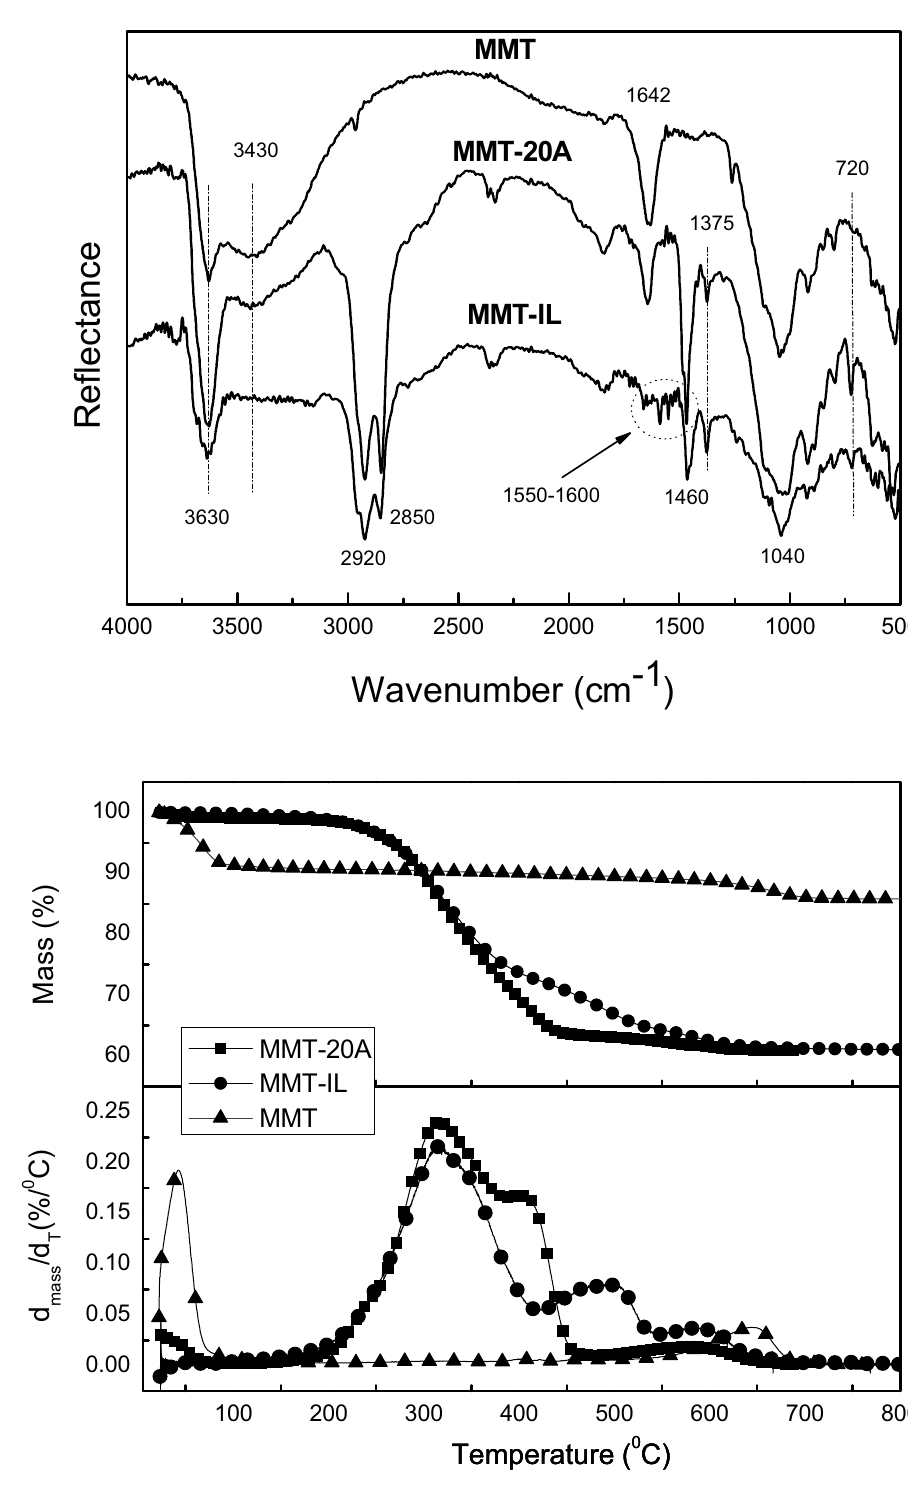
Fig. 3 FTIR spectra of pristine MMT and organically modified MMT samples